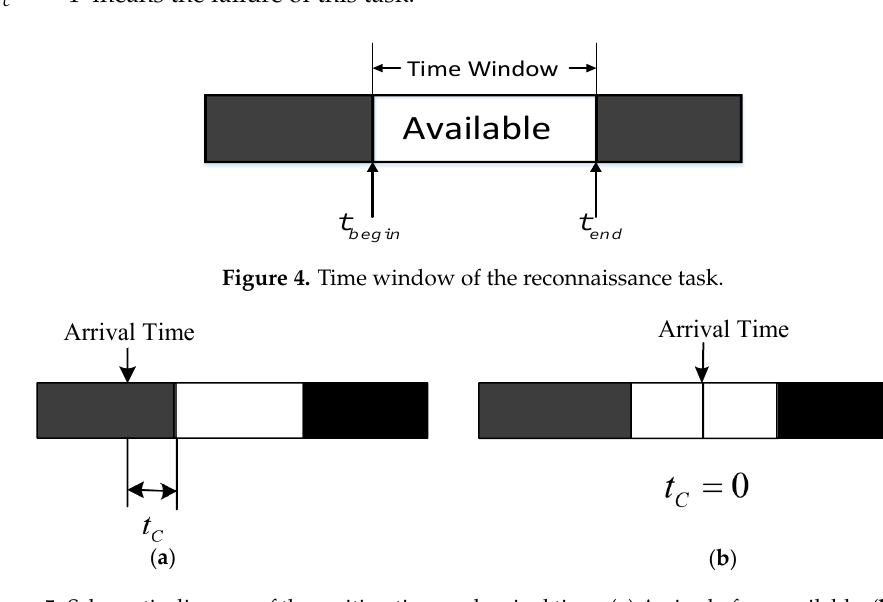
Figure 5. Schematic diagram of the waiting time and arrival time. ( a ) Arrive before available; ( b ) Arrive when available.